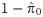
Determining which genetic variants affect TF binding.(A) ASH p-value densities for heterozygous SNPs in different categories (the dotted blue line represents the null distribution). Numbers shown are the estimated proportion of true signal, i.e., 1-π^0. (B & C) Precision versus Recall operating curve (PROC) comparing CENTIPEDE predictions to (B) dsQTLs (Degner et al., 2012) [23] and (C) CTCF binding QTLs (Ding et al., 2014) [24]. For our annotation (in purple), the line is drawn for different threshold on what is considered an effect-SNP, with the (x) indicating all footprint-SNPs and the (+) indicating the default threshold of 20x difference between alleles. (B) Except for CATO (Maurano et al., 2015; dark blue) [17] and our annotation, the other prediction methods were already included in Lee et al. (2015) [18]. Note, the curve of some methods do not end at the lower-right corner because not all the dsQTLs have an annotation (e.g., if they are not in footprints). (C) For both CATO and effect-SNPs we only considered CTCF motifs, while for the methods that are not TF-centric all the scores are used. (D) Comparison of predicted binding effect for CTCF footprint-SNPs to CTCF-QTLs. Each dot represents a SNP within a CTCF binding region (ChIP-seq peak) and in a CENTIPEDE footprint with the same color annotation as in (A), the x-axis shows the predicted change in binding and the y-axis the QTL effect size for the alternate allele.